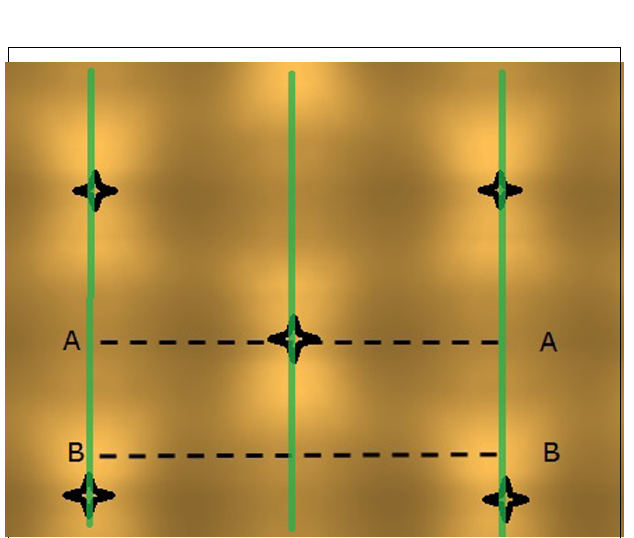
FIGURE 3 | Projected light pattern of HPS lamps without plants, on a horizontal plane at 2.5 m distance from the lamps, with sensor trajectories (A –A and B – B) indicated by dashed lines, lamp positions are shown by star-like symbols, and the double plant rows by green lines.